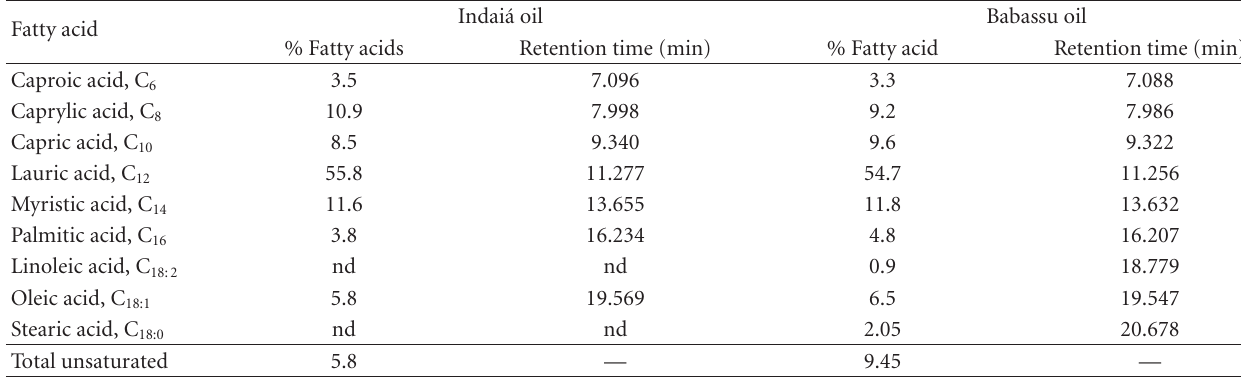
Table 3: Fatty acid composition (mean percentage) of indai´a and babassu oils.